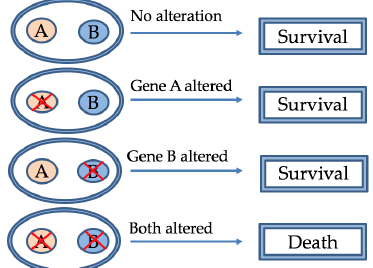
Figure 1. Synthetic lethality: Synthetic lethality occurs when the simultaneous mutation of two genes is lethal for the cell, while mutation in each individual gene is not.